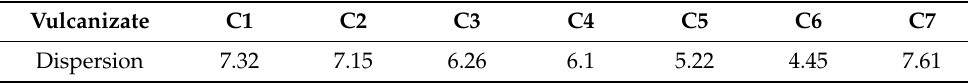
Figure 6. Dispersion images. ( C1 – C7 ) are the dispersion images of 7 groups of rubbers. Table 2. Dispersion values.